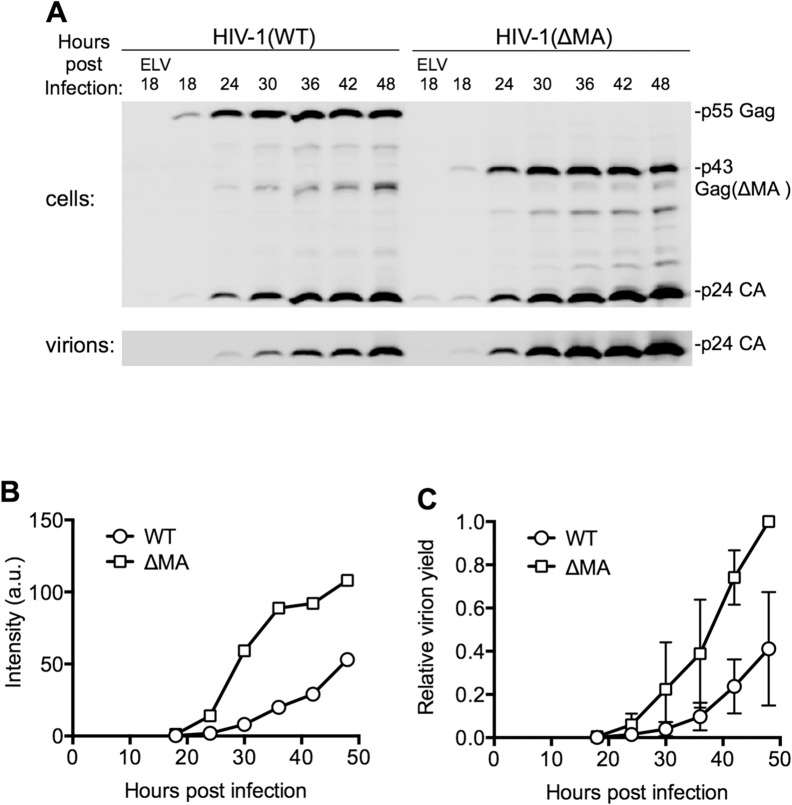
Effect of the MA globular head on the dynamics of HIV-1 replication.(A) Representative Western blot (anti-CA) analysis of cell and virion associated Gag following infection with HIV-1(WT) and HIV-1(ΔMA) at an MOI of 0.7. Cells and virons were harvested at the indicated times after infection. ELV, Elvitegravir, an integrase-inhibitor was added to some samples to block infection to indicate background levels of CA due to input virus. (B) Quantitation of the intensity of the virion-associated CA from the experiment shown in (A), using LiCOR Odyssey scanner, and assigned arbitrary units (a.u.). (C) Quantitation of the intensity of the virion-associated CA following infection on MT4 cells with HIV-1(WT) and HIV-1(ΔMA) at an MOI of 0.2 to 1. Values were normalized to the maximum level of virus release in each experiment, that was arbitrarily assigned a value of 1. The mean ± sd (n = 4 to 7) for each time point is plotted.